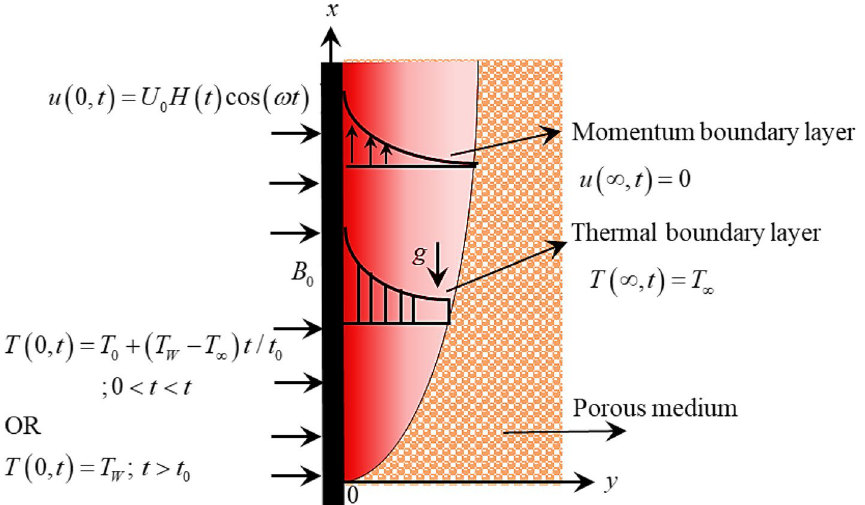
Figure 1. Physical sketch and coordinate